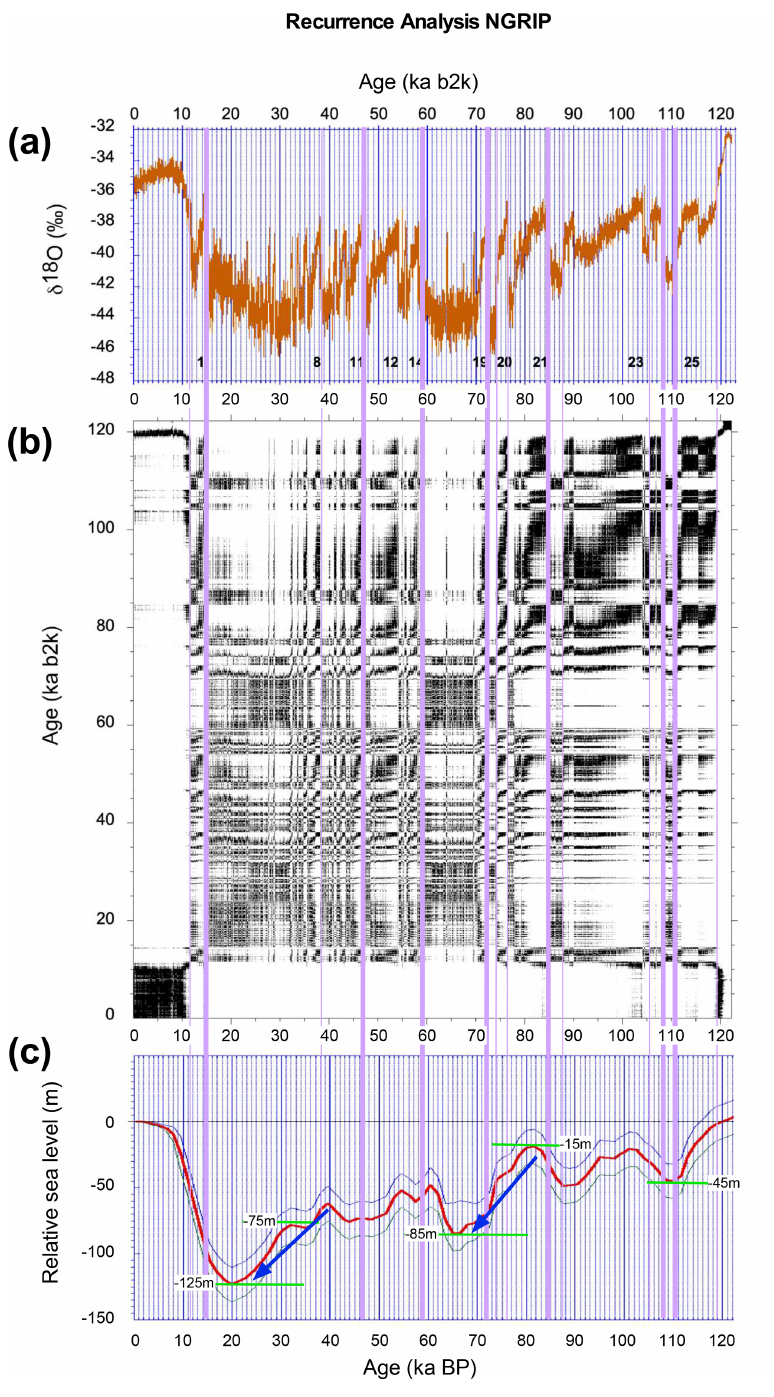
Figure 5. Recurrence analysis of NGRIP δ 18 O. (a) NGRIP δ 18 O variations over the last 122kyrb2k (Rasmussen et al., 2014); same as in Fig. 4a. Panel (b) is the same as Fig. 4b. (c) Variation of the sea level over the last 122kyrBP as reconstructed from benthic δ 18 O foraminifera by Waelbroeck et al. (2002). The bold red line is the global mean sea level (m) below present, and the light blue lines are the minimum and maximum global mean sea level values (m) below present. The horizontal green line segments indicate some key sea levels. The RP web site is